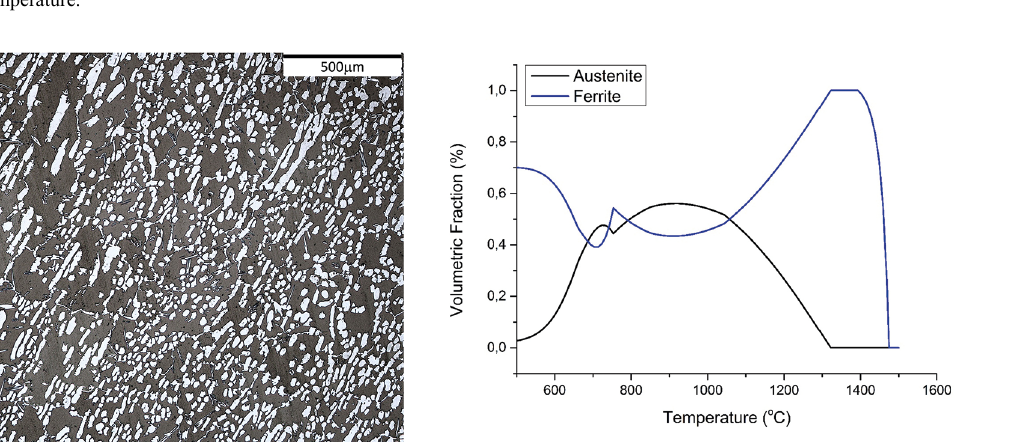
Figure 2. Weight fractions of austenite and ferrite in function of temperature calculated by computational simulation in the Software Thermo-Calc for UNS